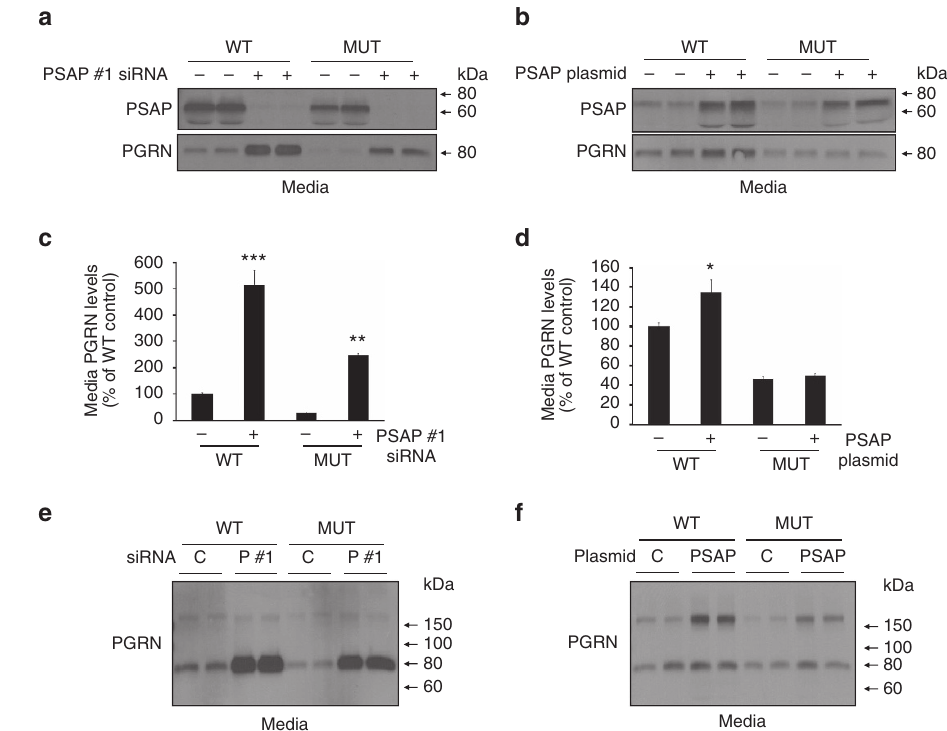
Figure 8 | PGRN levels and oligomerization are changed in human fibroblasts derived from individuals with and without GRN mutations. ( a , b ) Immunoblots of media and lysates obtained from wild type (WT) or GRN mutant (MUT) human fibroblasts transfected with either control or PSAP siRNAs ( a ), or with either control or PSAP plasmids ( b ). ( c , d ) Quantification of PGRN immunoreactivity in media from WTor GRN mutant (MUT) human fibroblasts transfected with either control or PSAP siRNAs ( c ) or with either control or PSAP plasmids ( d ) ( n ¼ 3 per group). ( e , f ) Immunoblot of BS 3 -crosslinked media obtained from WT or GRN mutant (MUT) human fibroblasts transfected with either control or PSAP siRNAs ( e ) or with either control or PSAP plasmids ( f ). Graphs represent the mean ± s.e.m. *Differs from control-transfected cells of the same cell line, P o 0.05, ** P o 0.01, *** P o 0.001 by one-way ANOVAs.